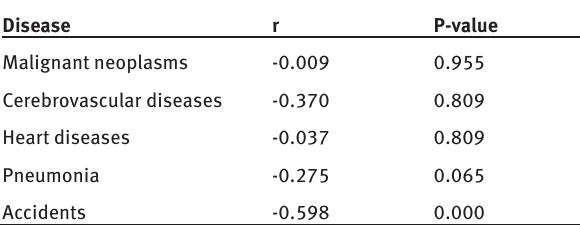
Table 3: The relationship between CT utilization rate and